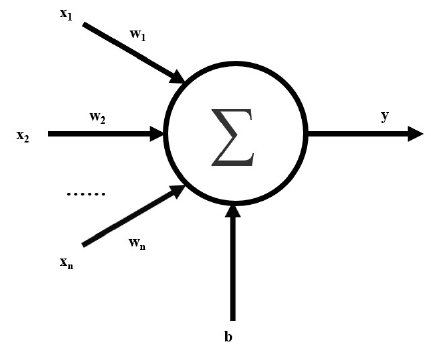
Figure 2. M-P neuron model.